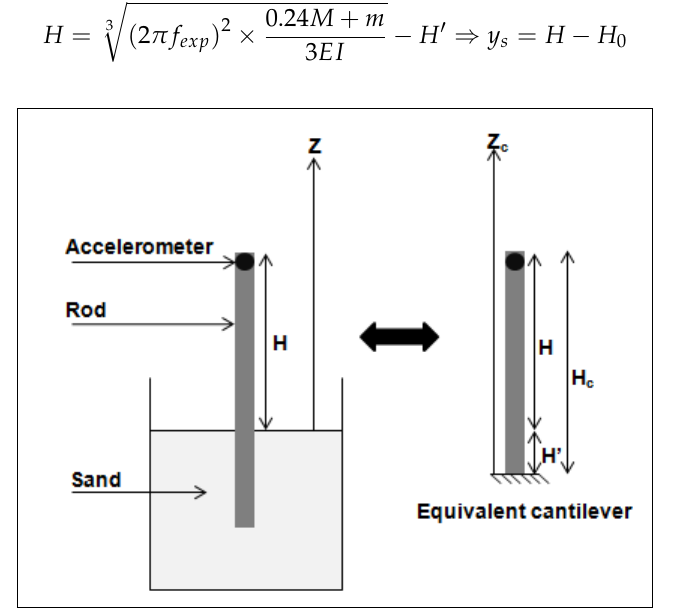
Figure 12. Equivalent cantilever of the dynamic soil structure interaction